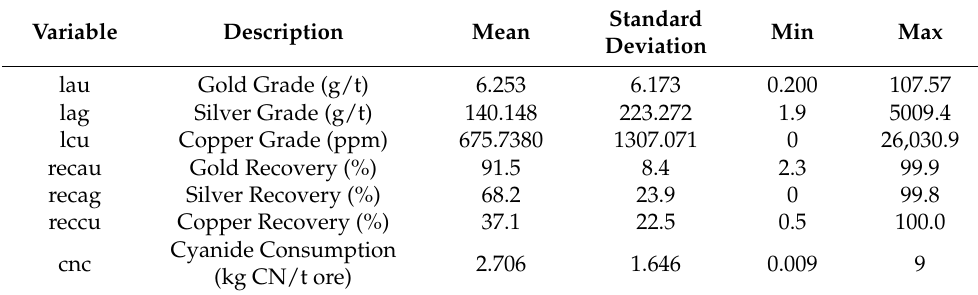
Table 2. Descriptive statistics of the bottle roll test parameters that were used as input data (n = 2678 samples).